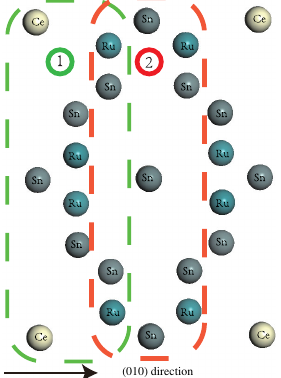
FIG. 7. Two different cleavage surface layers in the (010) direction enclosed by the green and red dashed lines.